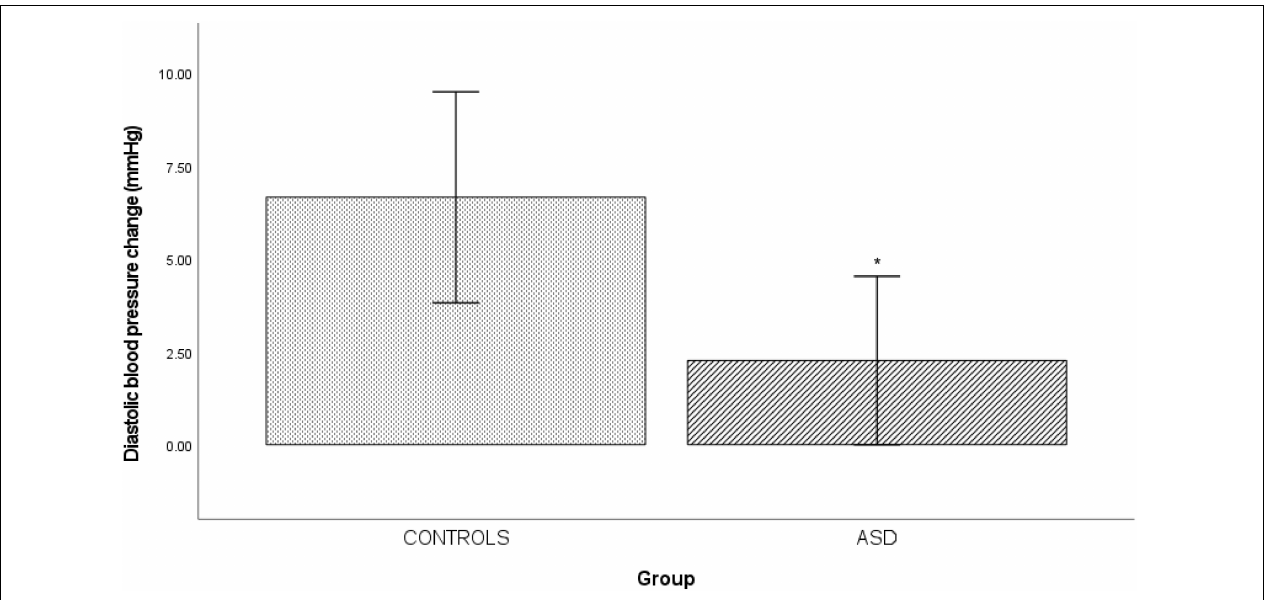
FIGURE 5 | Changes in mean diastolic blood pressure from baseline during mental arithmetic in controls and ASD. mmHg, millimete r s of mercury. *Refer to a statistically significant finding.